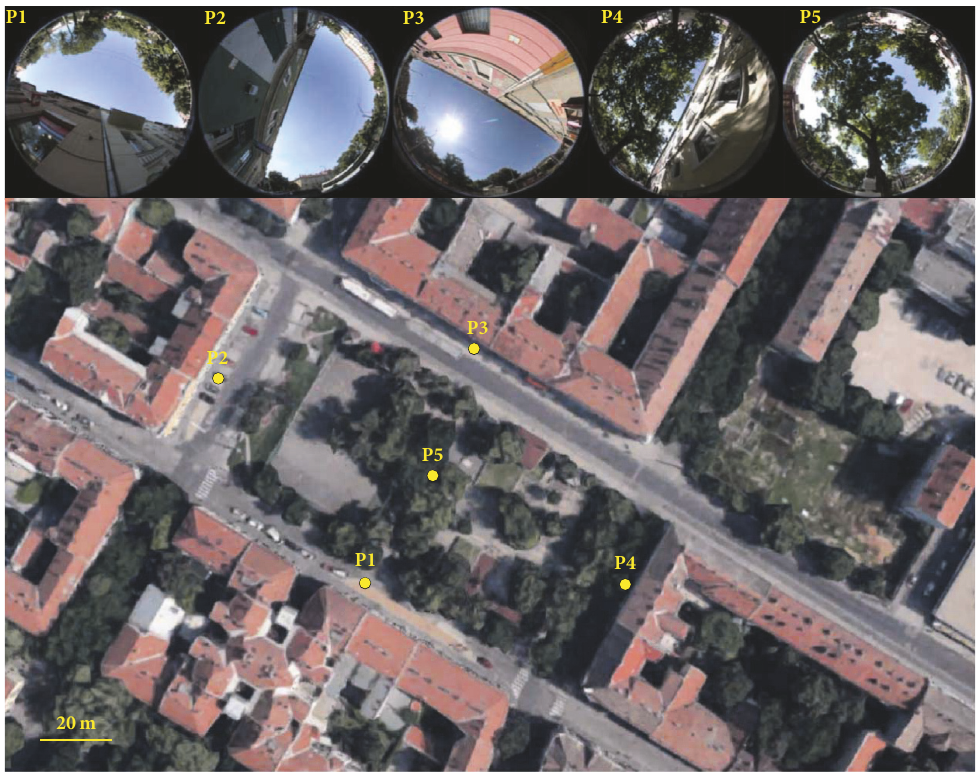
Figure 2: Survey points in the Bart´ok Square with their fish-eye photographs.